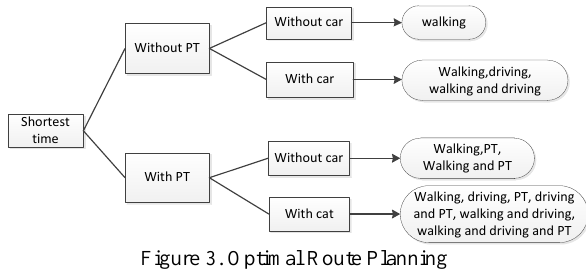
Figure 3. Optimal Route Planning